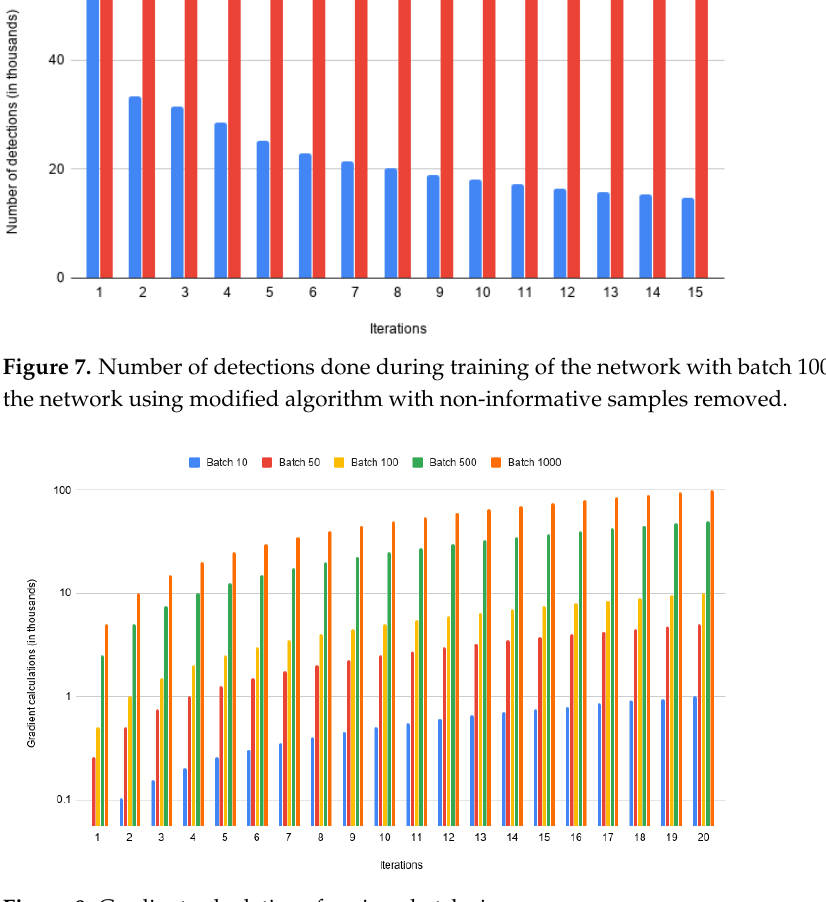
Figure 8. Gradient calculations for given batch